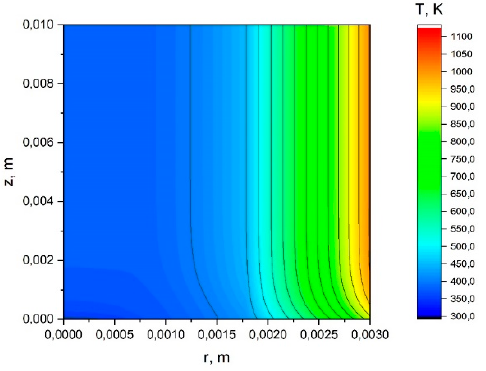
Figure A14. Temperature distribution in the stem of a herbaceous plant: R = 0.003 m, t = 6 s, q = 30 kW/m 2.